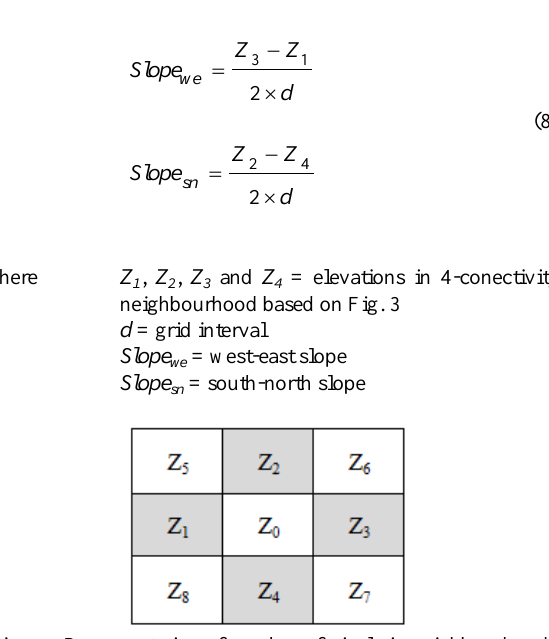
Figure . Representation of number of pixels in